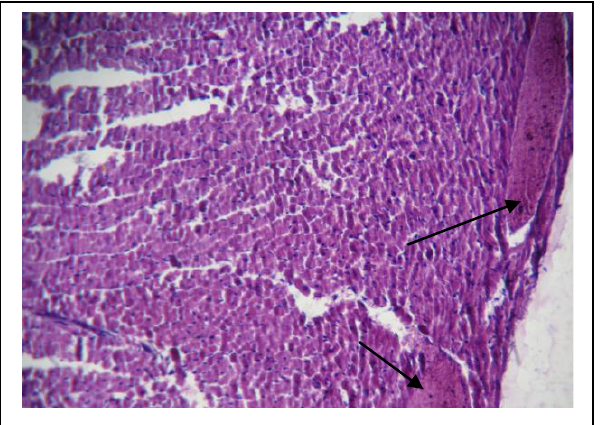
Figure(6):There is lymphatic infilteration( ),vacculation( ),coagulative necrosis( ) and few emosidrin pigment( ) in the liver. (H&E ×40)